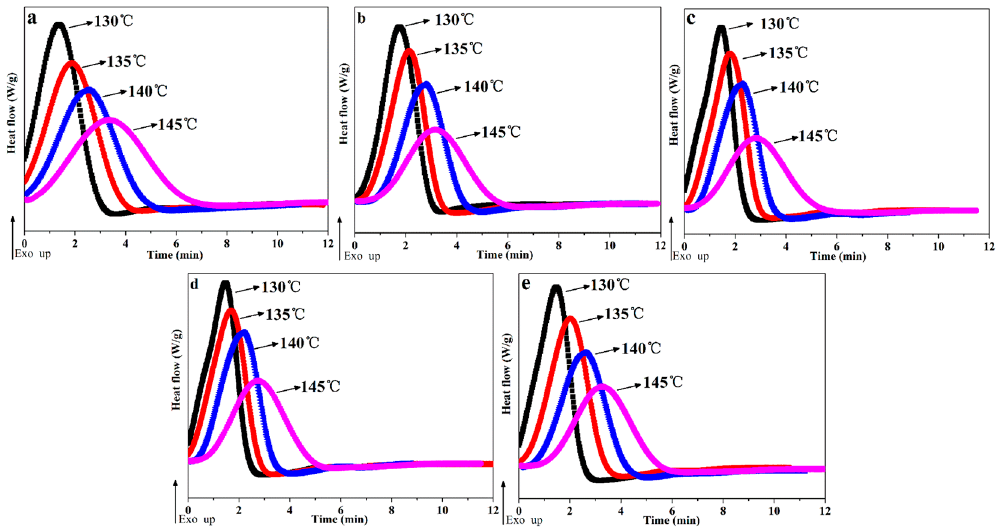
Figure 4. Isothermal crystallization exotherms for POM / Ag nanocomposites: ( a ) POM, ( b ) POM-1, ( c ) POM-2, ( d ) POM-3 and ( e ) POM-4. Table 3. The time for isothermal crystallization of POM / Ag nanocomposites.